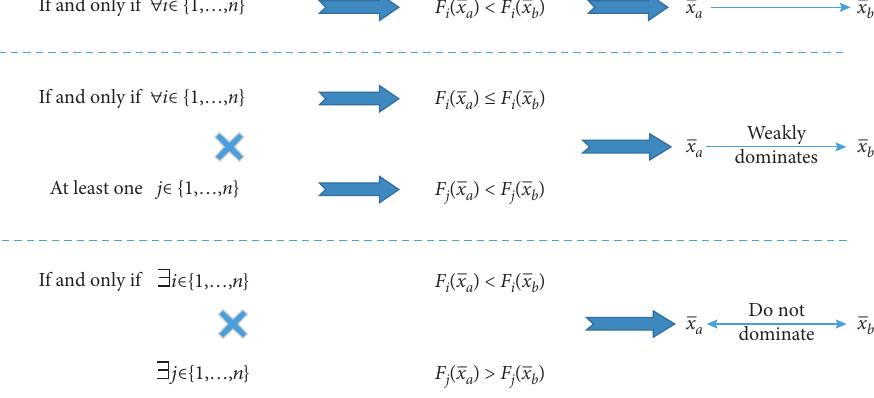
Figure 6: Decision-making relationship.